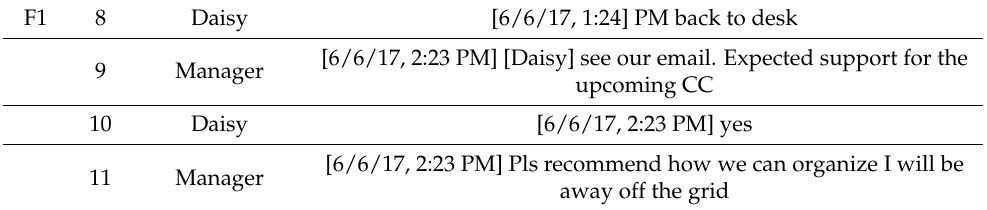
Table 3. F1 (“Back to Work”